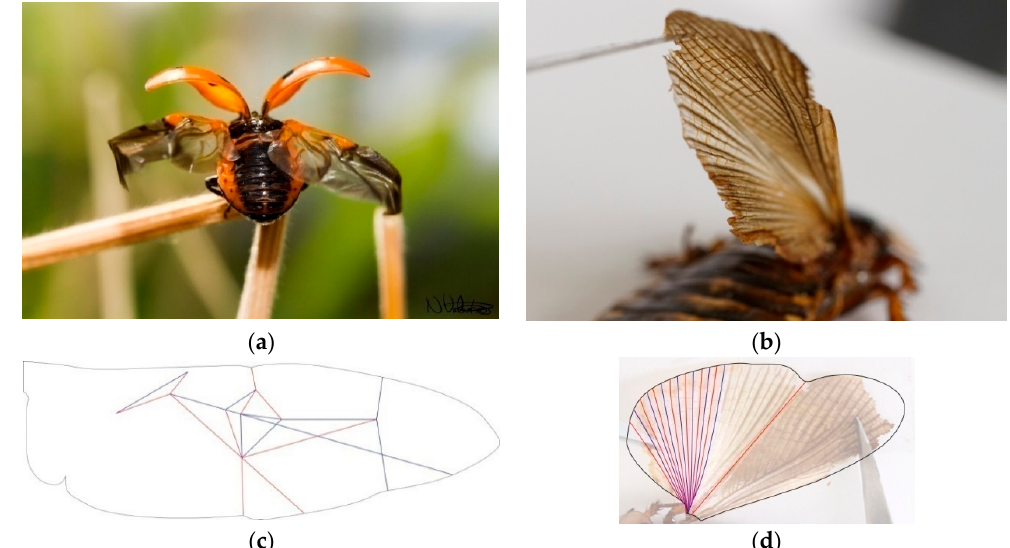
Figure 3. Pictures of the biological role models studied and drawings of their crease pattern on top of the unfolded state. ( a ) Presents a Coccinellidae unfolding its wings ( © Flickr, Nikk, CC BY 2.0). ( b ) Image of a Blaptica dubia wing. ( c ) Displays the wing folding pattern of a Coccinella septempunctata based on drawings from Saito et al. who performed microcomputed tomographyof the wing to view the folded state. ( d ) Shows the folding pattern of the Blaptica dubia wing drawn over a photograph.